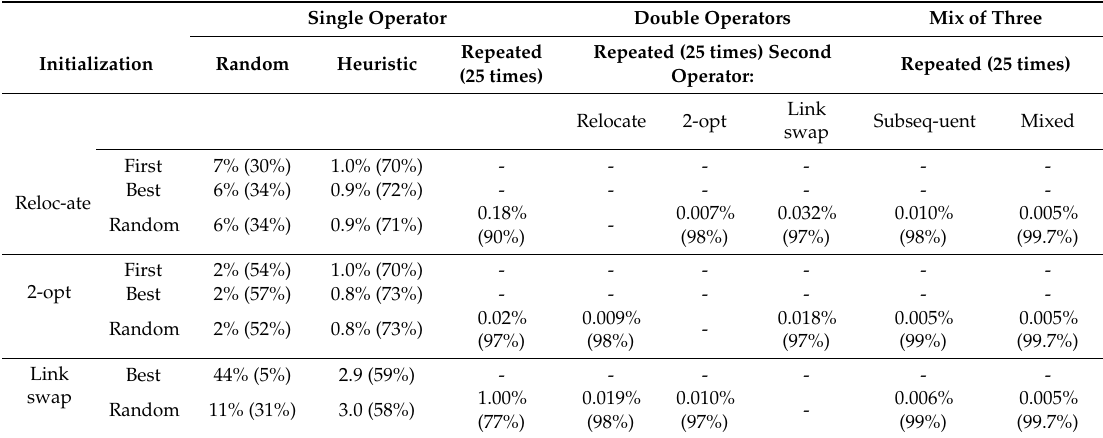
Table 2. Combined results of single and subsequent application of random improvement with di ff erent operators averaged over O–Mopsi and Dots instances. The percentage of solved instances are shown inside the parenthesis. The number of iterations was fixed to 10000 for randomized search, whereas first and best improvements were iterated until convergence.